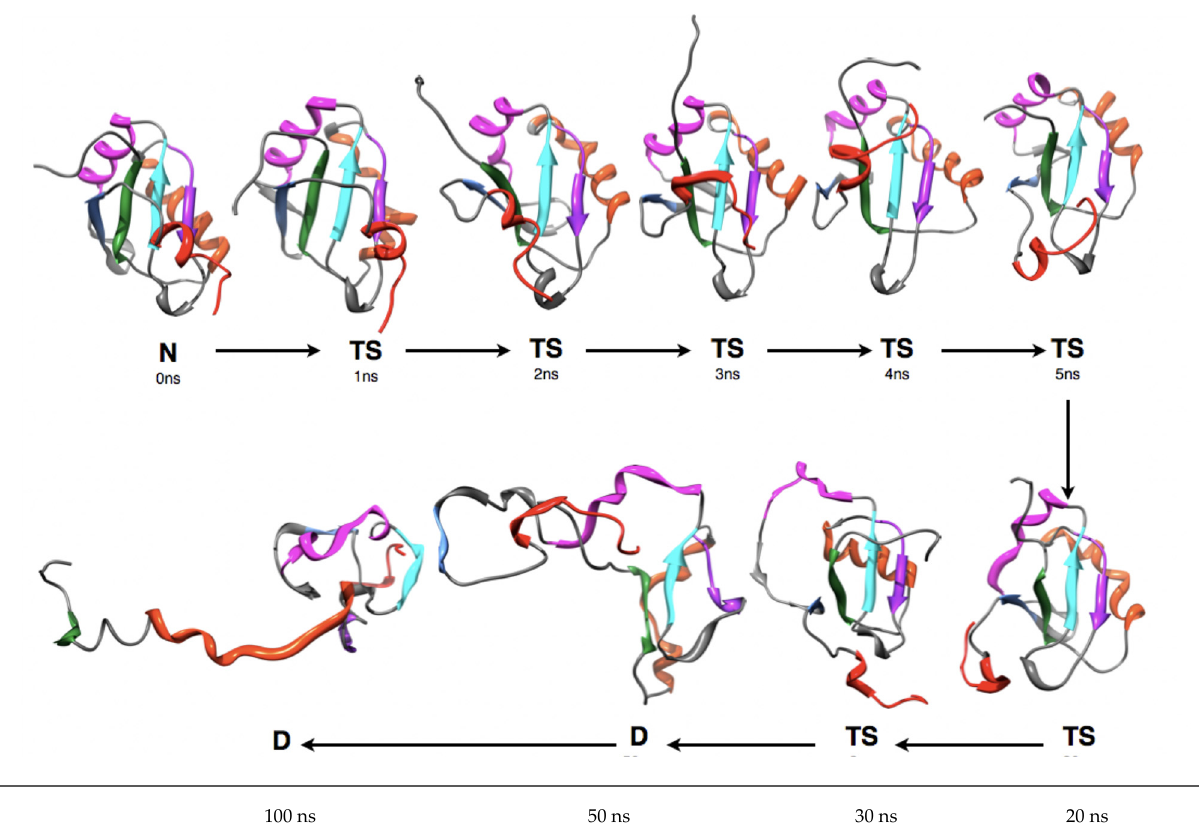
Figure 8. A series of MD snapshots from 100 ns of the MDUF trajectory #1 for U1A.